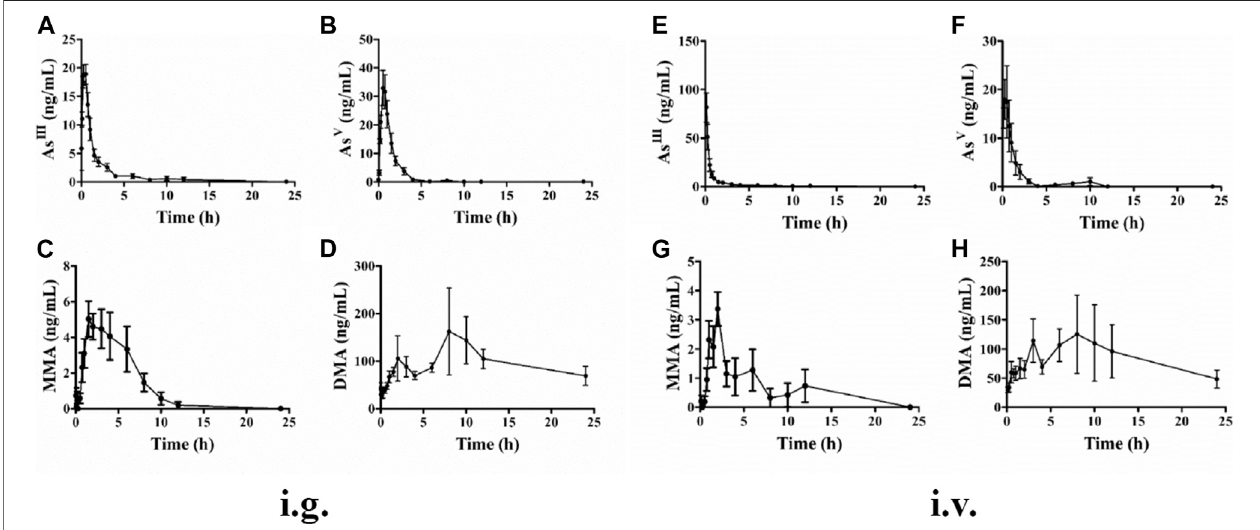
FIGURE 2 | Mean plasma concentration-time curves of rats As III , As V , MMA V , and DMA V after intragastric (A – D) and intravenous (E – H) administration to a single dose (1 mg kg − 1 ). Data were shown as mean ± SEM. ( n (cid:2) 5 for each group).